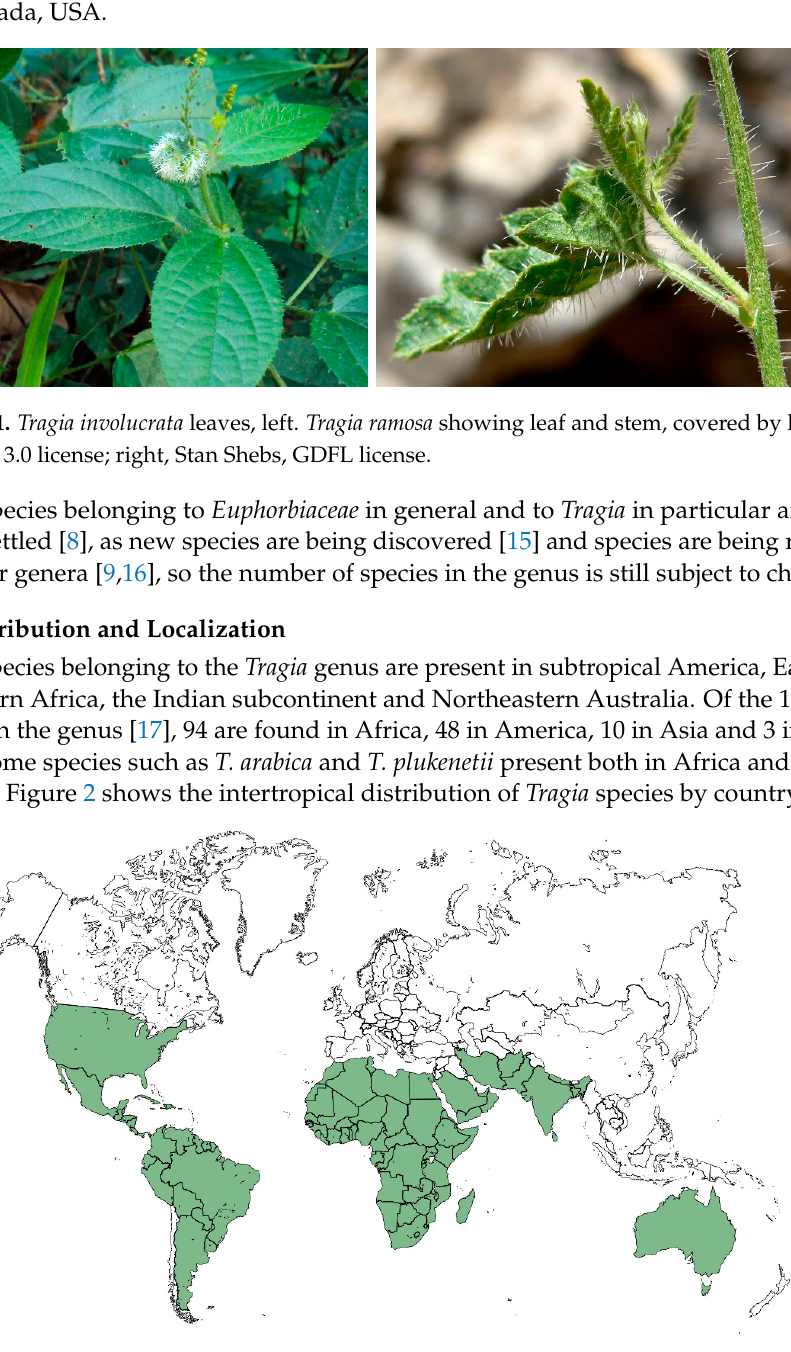
Figure 2. Worldwide Tragia species distribution, by country.